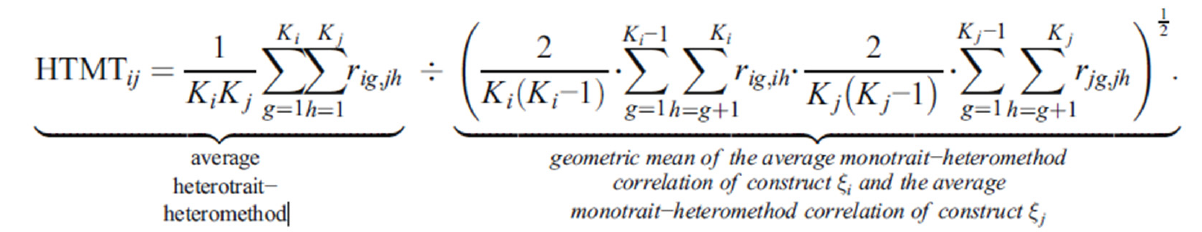
Figure 2. Equation for HTMT method.